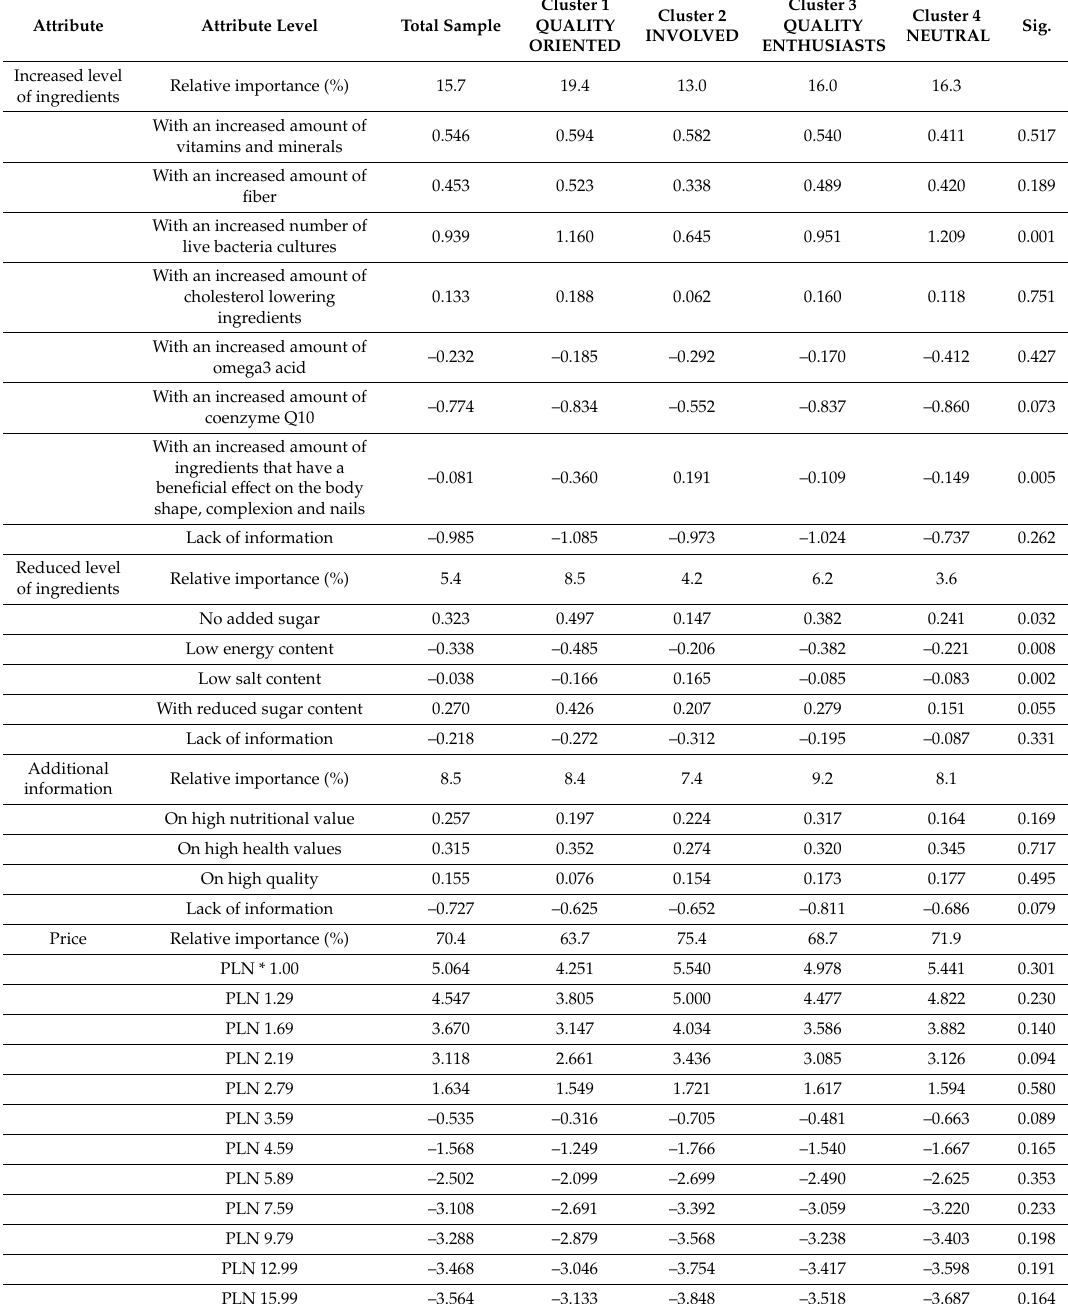
Table 7. The part-worth utilities and relative importance of attributes for total sample and four identified clusters ( N =